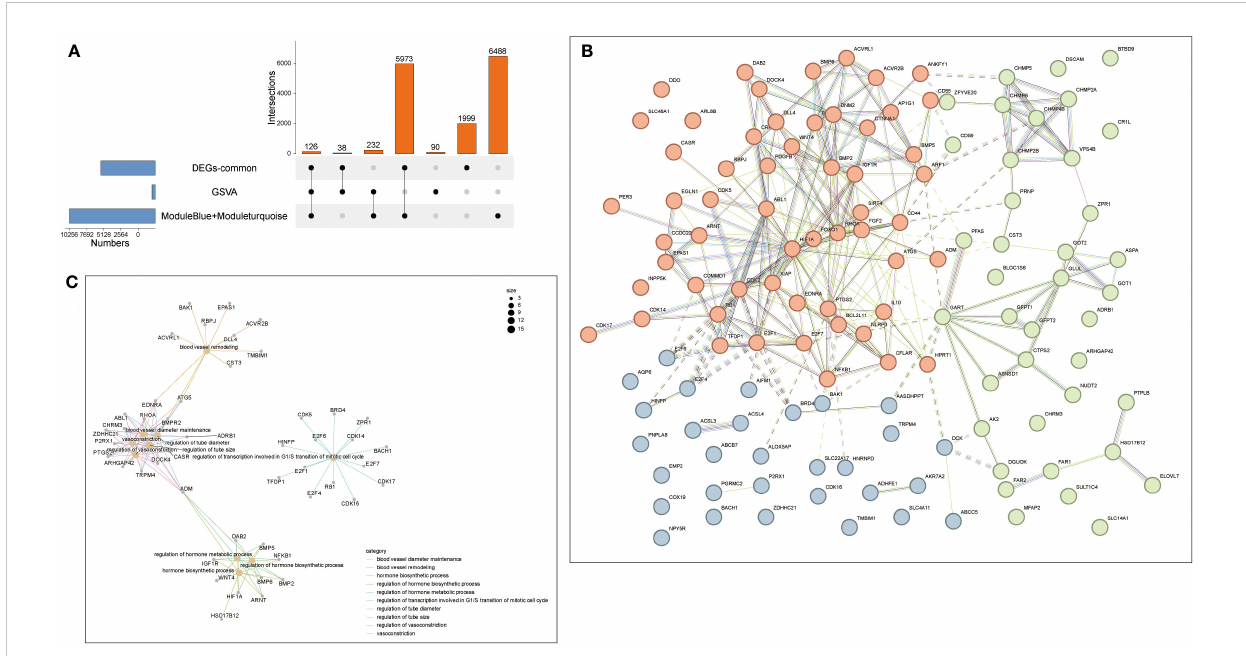
FIGURE 7 Protein-Protein Interaction Network (PPI). (A) The Venn diagram showed that seven algorithms have screened out 16 overlapping hub genes in NAFLD and Sarcopenia. (B) PPI network diagram. (C) The GO biological process analyses overlap genes from (A)